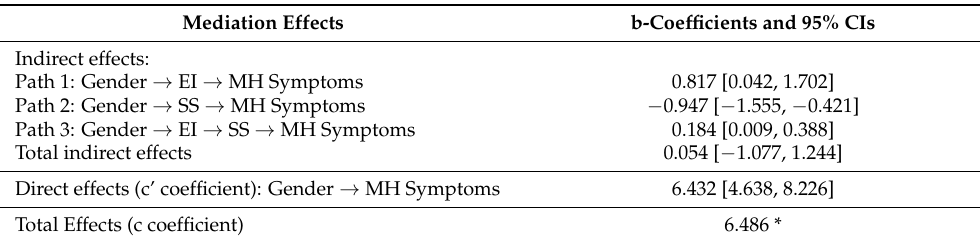
Table 4. Significant indirect, direct and total effects (b-Coefficients and 95% CIs) of gender (IV), emotional intelligence (M1), and social Support (M2) on mental health